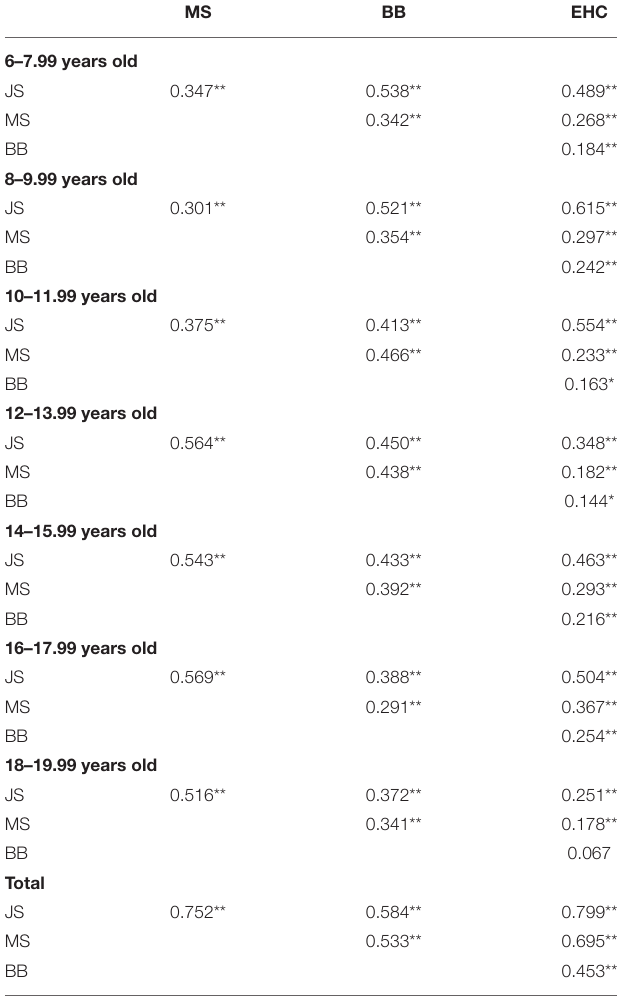
TABLE 2 | Correlations between the four items of the KTK3 + test battery in total and per age